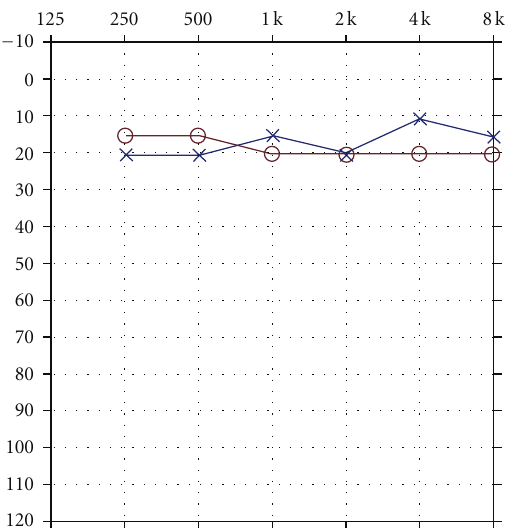
Figure 6: Audiogram depicting normal peripheral auditory sensi- tivity for both ears.